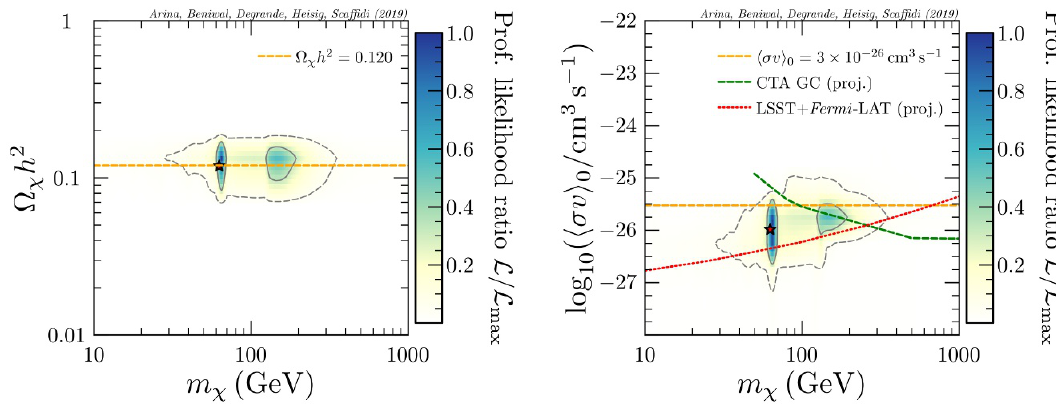
Figure 9 . 2D PLR plots for the pNG DM relic abundance and its annihilation cross section today after post-processing our samples with Fermi -LAT likelihood from 45 dSphs. In the right panel, projected limits from CTA GC searches [92] and LSST+ Fermi -LAT dSphs [90] are also